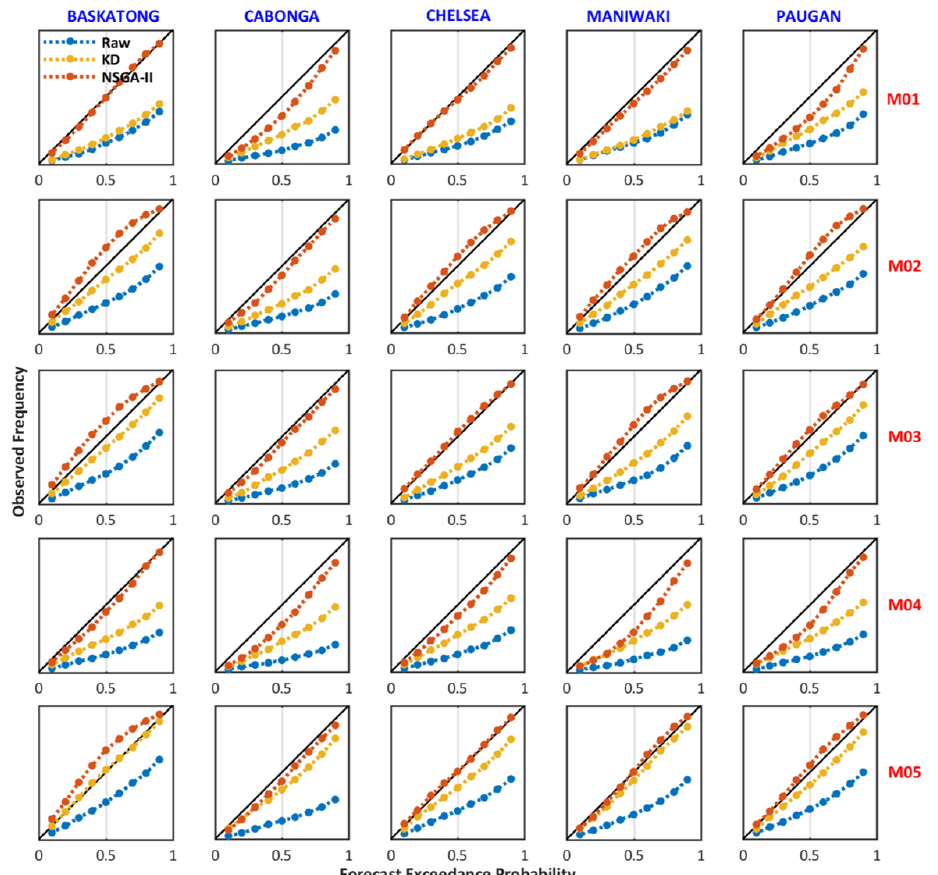
Figure 7. Forecasting reliability of the raw, AKD, and NSGA-II forecasts on the calibration dataset (4d ahead forecast) for five single-model H-EPSs over each individual catchment (January 2011–December 2016).